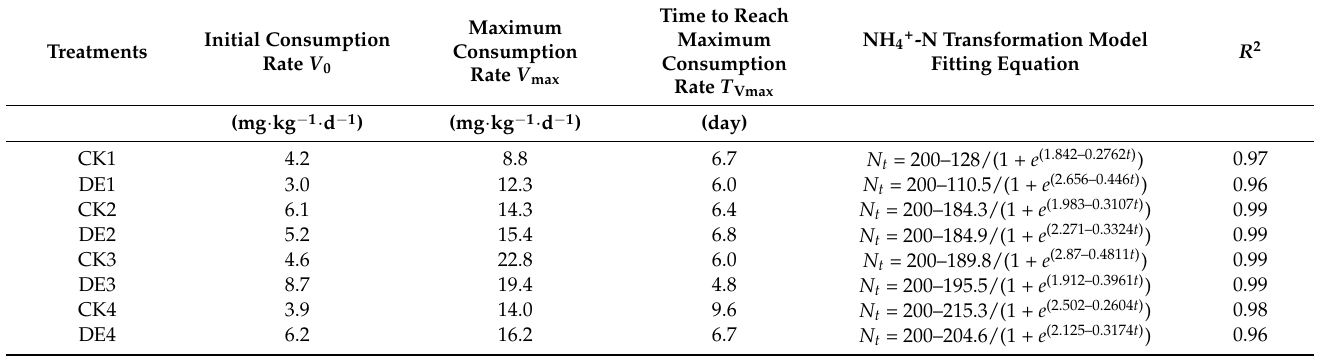
Table 3. Characteristic values of the fitting model of the soil NH 4+ -N consumption in different treatments.